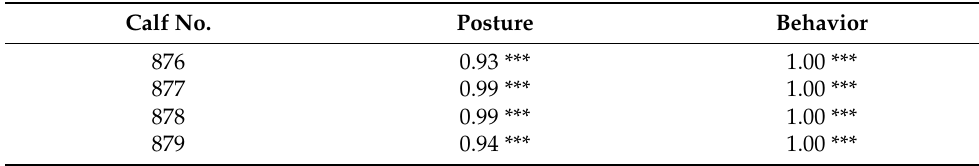
Table 6. Cohen’s kappa coefficient for each calf by posture (standing, moving, and lying) and behavior (rumination, eating, and